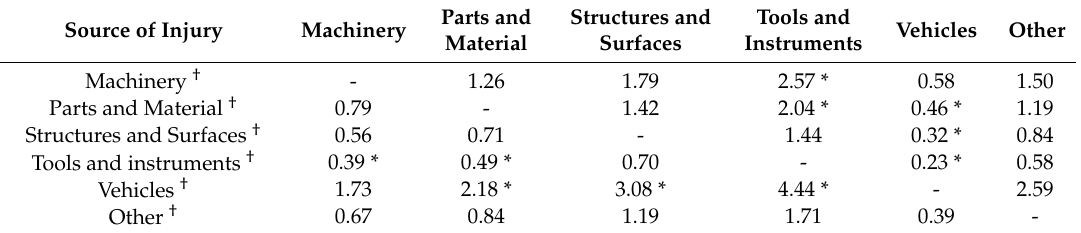
Table 9. Odds ratios of fatal accidents among di ff erent sources of injuries.